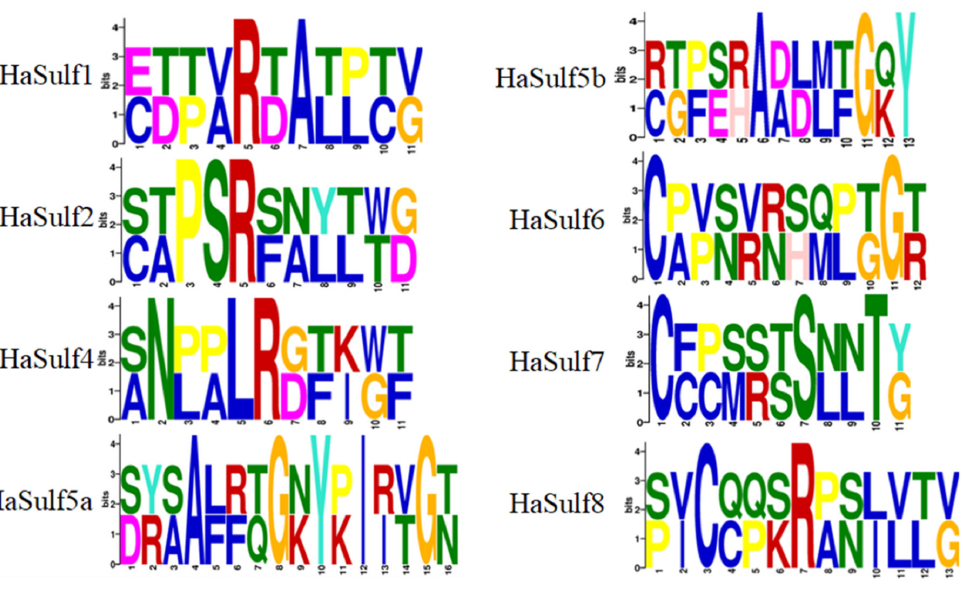
Figure 5. The core catalytic sequence of HaSulfs.